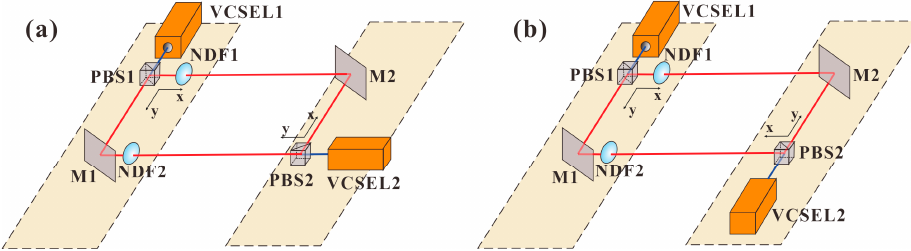
Figure 1. Schematic for polarization chaos in two mutually coupled VCSELs in two scenarios of ( a ) parallel injection and ( b ) orthogonal injection. VCSEL1 and VCSEL2, vertical-cavity surface- emitting lasers; PBS1 and PBS2, polarizing beam splitters; NDF1 and NDF2, neutral density filters; M1 and M2,